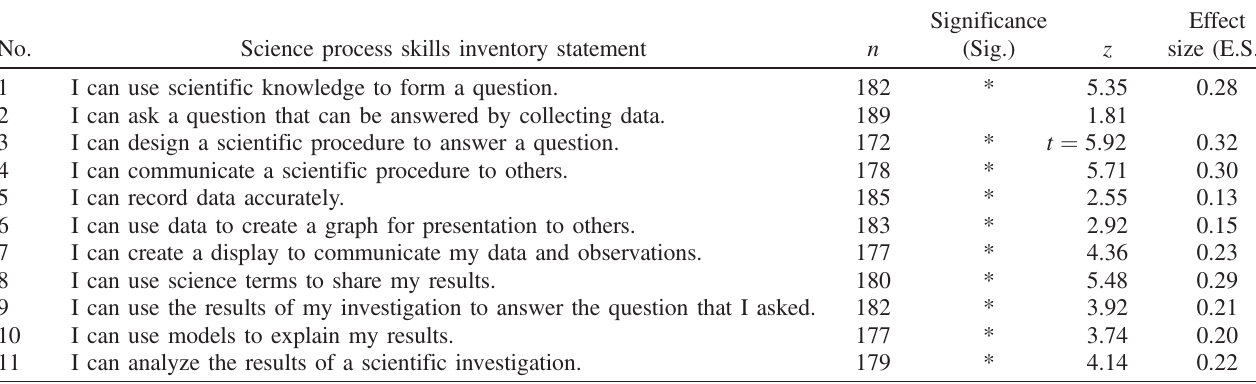
TABLE II. Significance ( α ¼ 0 . 05 ) and effect size (E.S.) associated with changes in students ’ responses after instruction compared to before instruction as measured by the sign test and t test. Statements for which statistically significant changes occurred are denoted with an